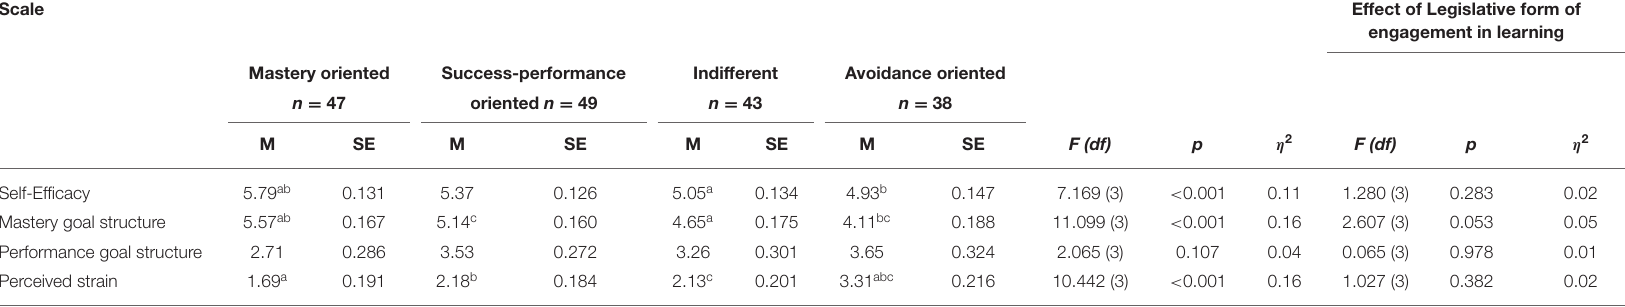
engagement in learning